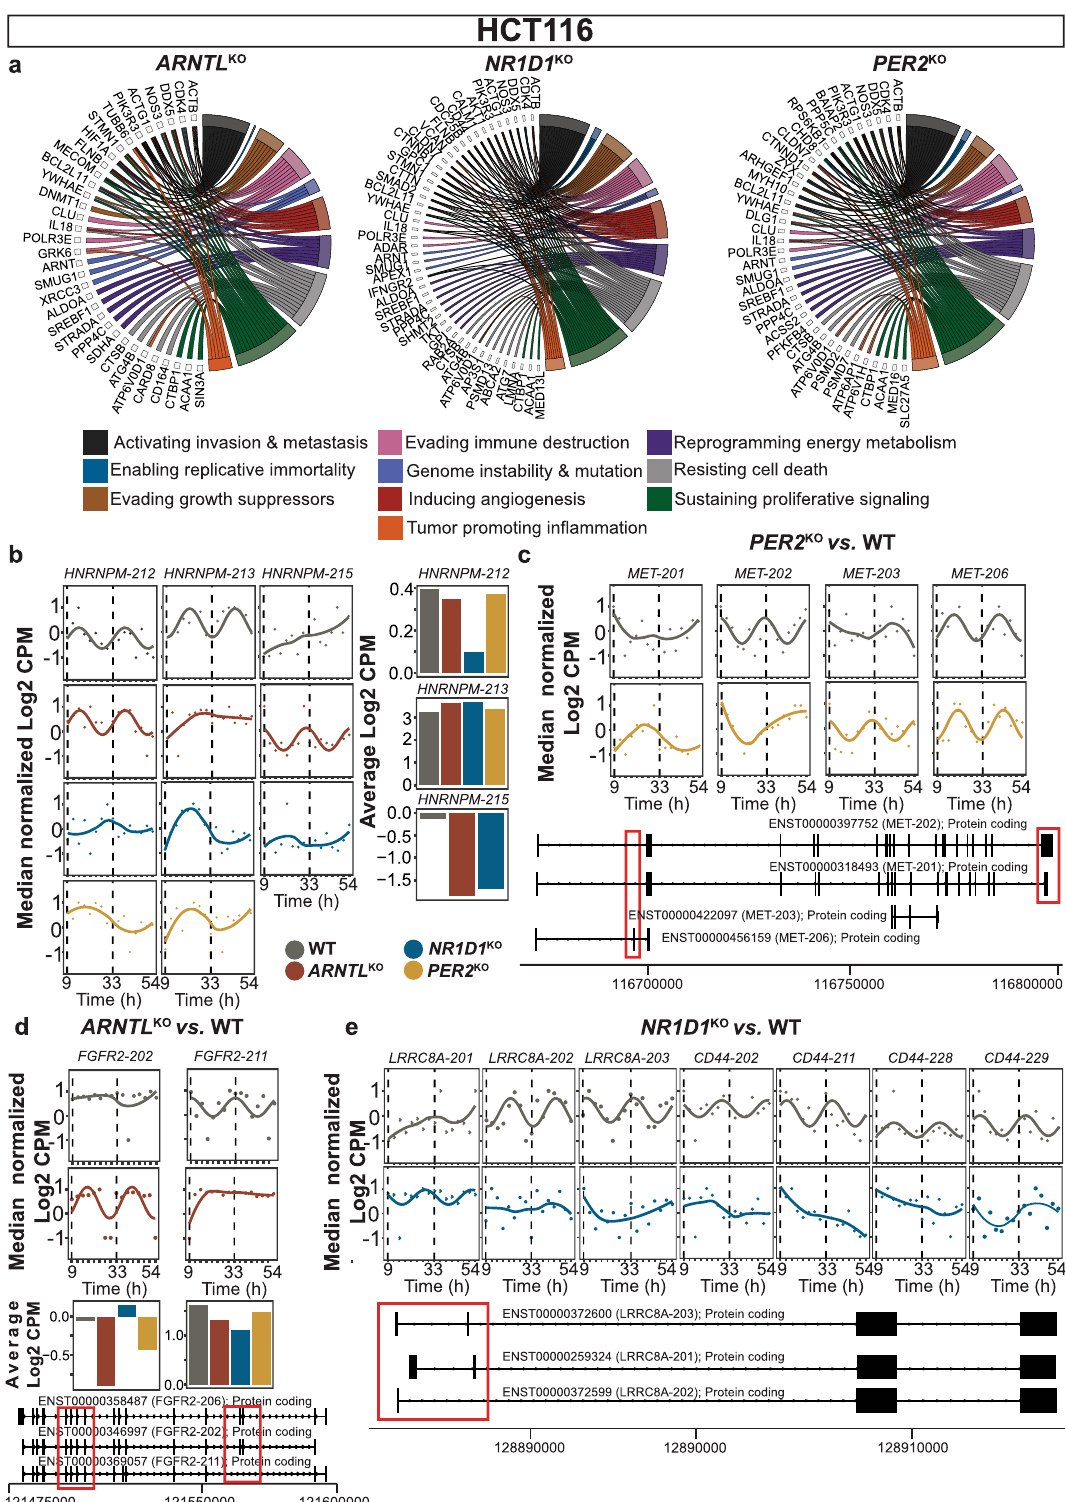
Fig. 6 Clock disruption in HCT116 resulted in alterations in AS in genes involved in the hallmarks of cancer. Commonly spliced and uniquely spliced candidates in HCT116 KO were mapped to the cancer hallmarks gene list. a Circular plots depict the association between spliced candidates and different cancer hallmarks ( b ) HNRNPM , a spliceosome machinery component lost its circadian expression in HCT116 KO cells. HCT116 KO cells also showed discrepancies in the mean expression level of HNRNPM transcripts. Expression of uniquely alternatively spliced candidate transcripts in ( c ) HCT116_ PER2 KO , ( d ) HCT116_ ARNTL KO , and ( e ) HCT116_ NR1D1 KO were plotted. Genomic region plots of MET , FGFR2 and LRRC8A transcripts represent differences in their exon composition (marked in red) compared to canonical forms. Circadian rhythmic transcripts were plotted using harmonic regression fi t and arrhythmic transcripts were plotted using Loess fi t in